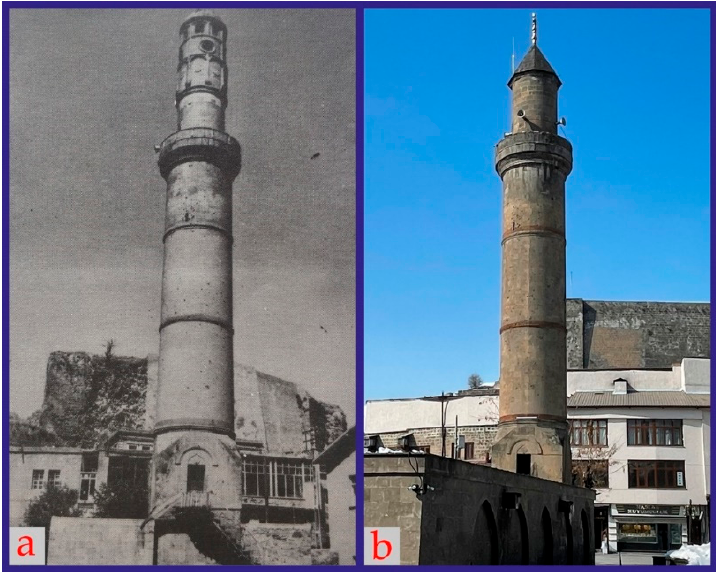
Figure 7. Bitlis Ulu Mosque’s minaret: ( a ) Arık (1971) [43]; ( b ) by authors (2022).